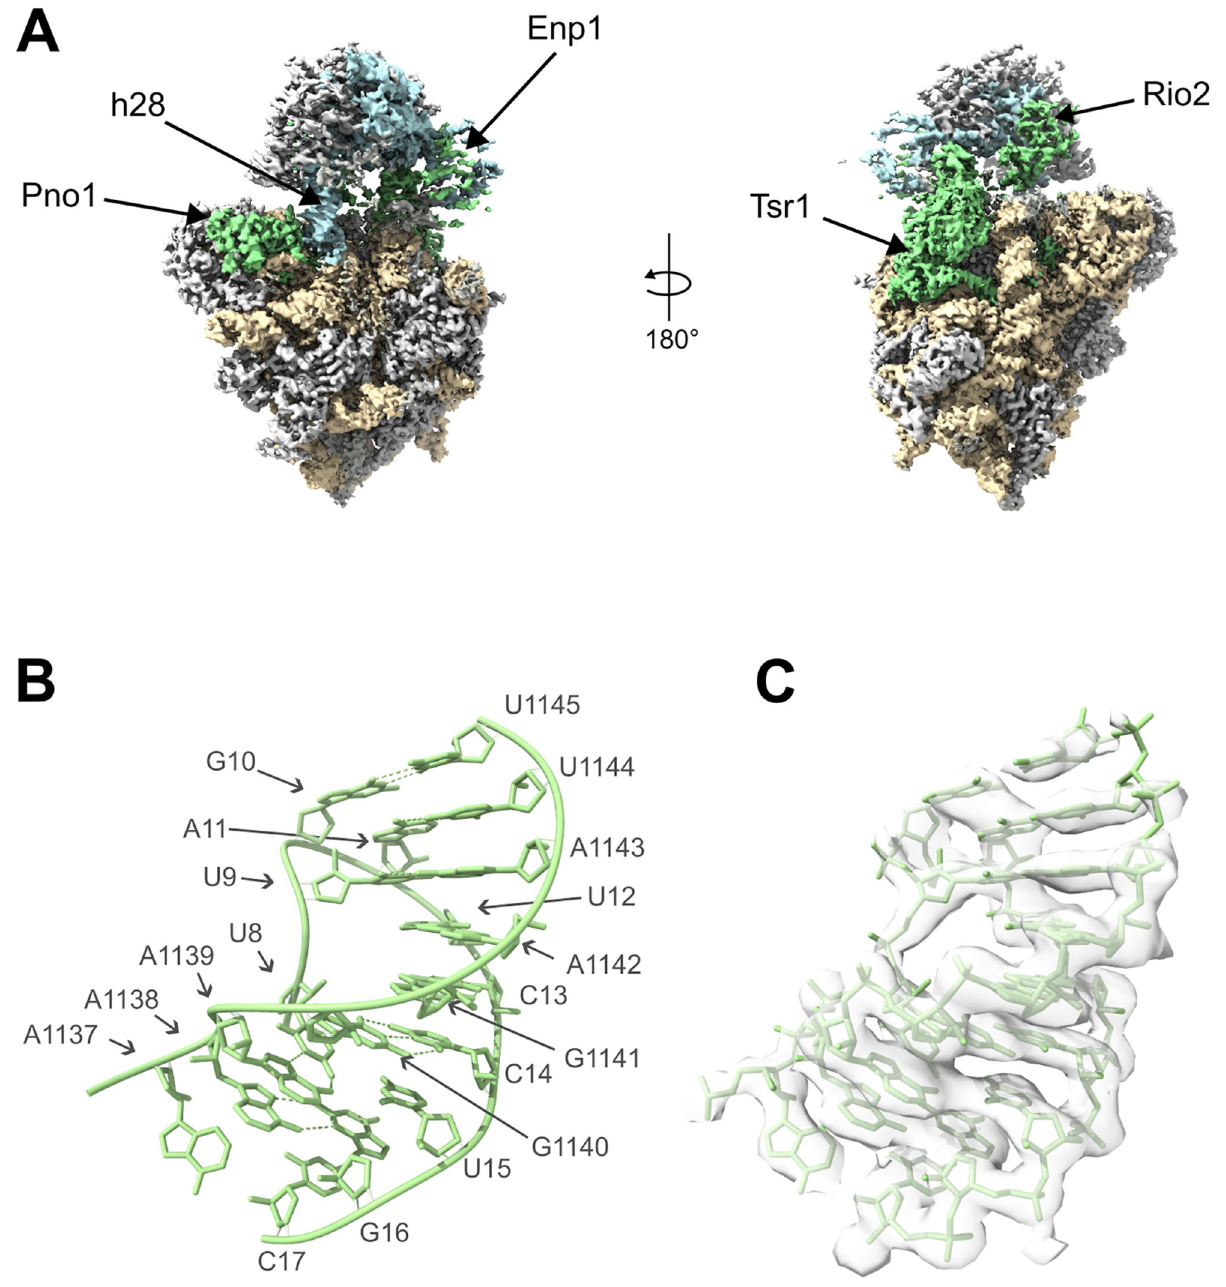
Fig 5. Incomplete S0-cluster assembly and CPK maturation in the Enp1TAP_B sub-population of SSU precursors. In (A) the cryo-EM derived map of the Enp1TAP_B particles is shown, in (B) the structure model of the CPK in these particles, and in (C) the structure model overlaid with the cryo-EM derived map of Enp1TAP_B particles. Coloring in (A) is done as described in the legend of Fig 1.